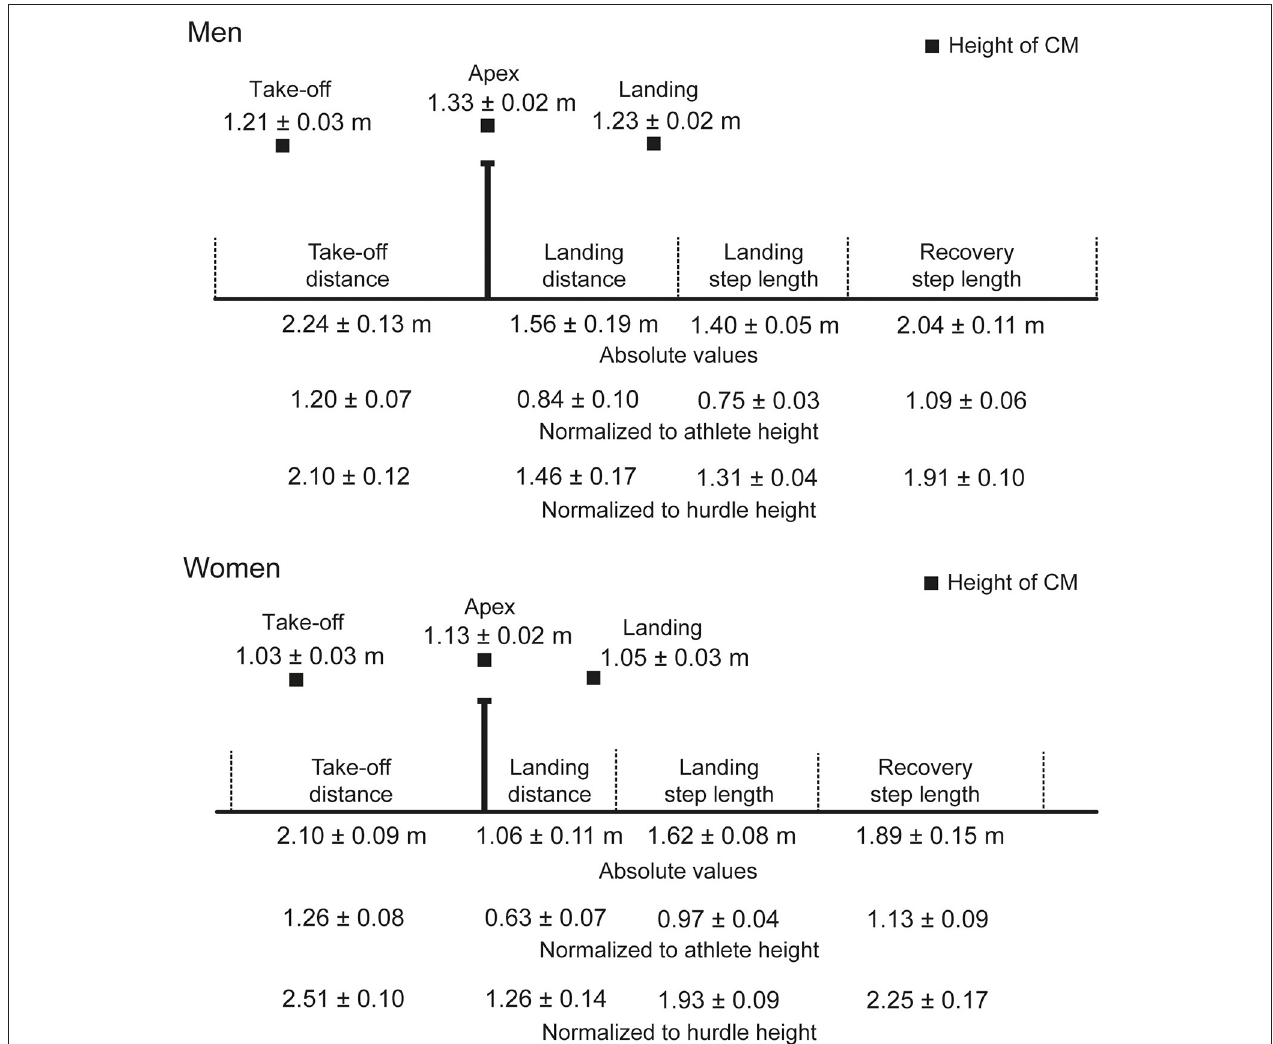
FIGURE 1 | Visual representation of the take-off and landing distances, landing and recovery step lengths, and the height of the CM at take-off and landing. The barrier is shown as the athletes would approach it running from left to right. The diagram is approximately to scale, with separate diagrams for men and women. The mean values ( ± SD) are shown as absolute values and, for the distances, as normalized to athlete and hurdle